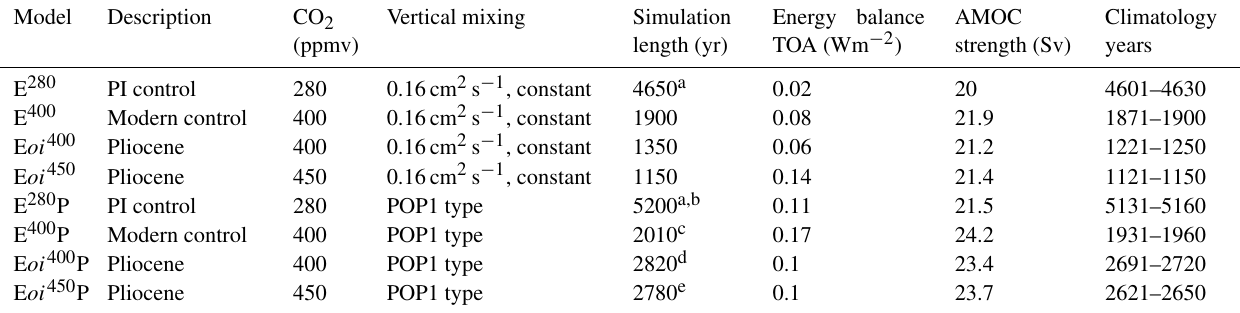
Table 2. Model details and diagnostics.